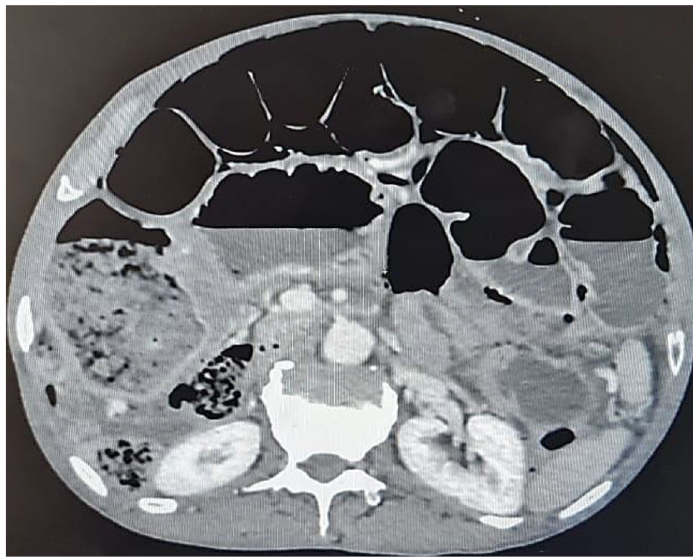
Figure 3. Multiple bubble lesions among ileal loops on Abdominal